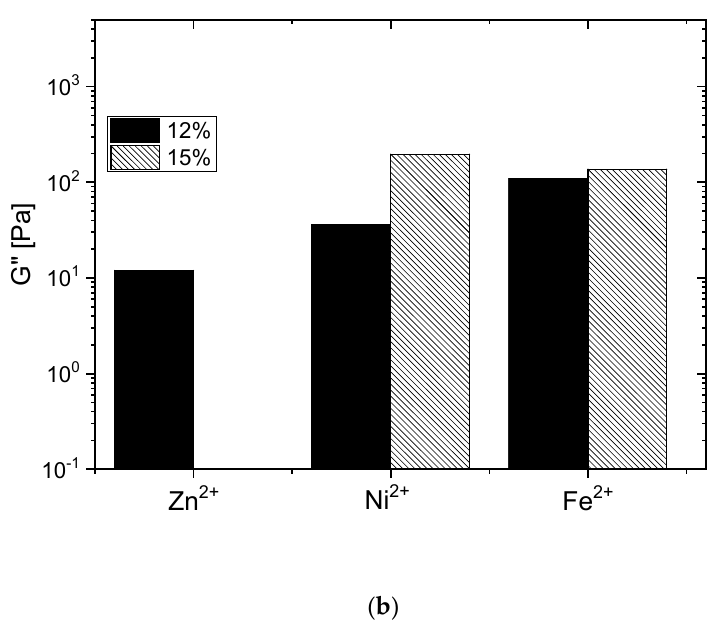
Figure 6. ( a ) Storage and ( b ) loss moduli, G ’ and G ”, at ω = 10 rad/s and T = 20 °C. The thick and thin horizontal lines are theoretical plateau modulus G N,theor0 for the 12- and 15-w/v% samples, respectively.